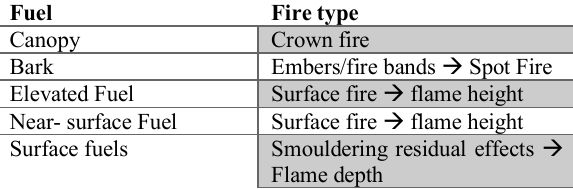
Table 2. Type of fire based on